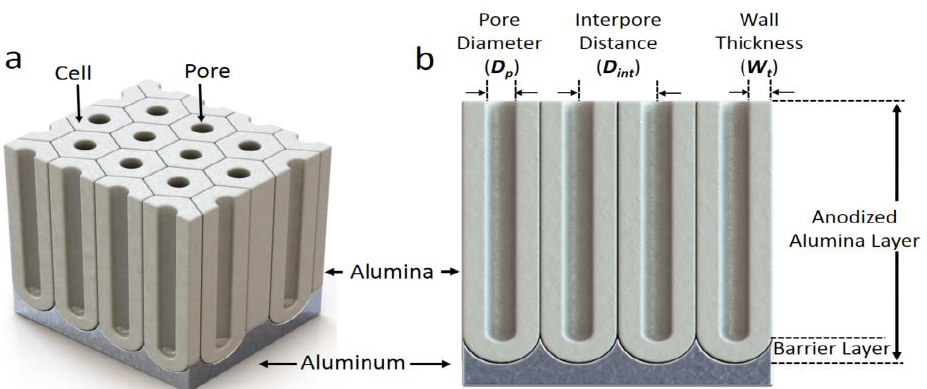
Figure 1. ( a ) Schematic of a typical hexagonal array of a nanoporous alumina layer formed by the anodization of aluminum. ( b ) A cross-sectional view of the anodized layer and structural parame- ters.